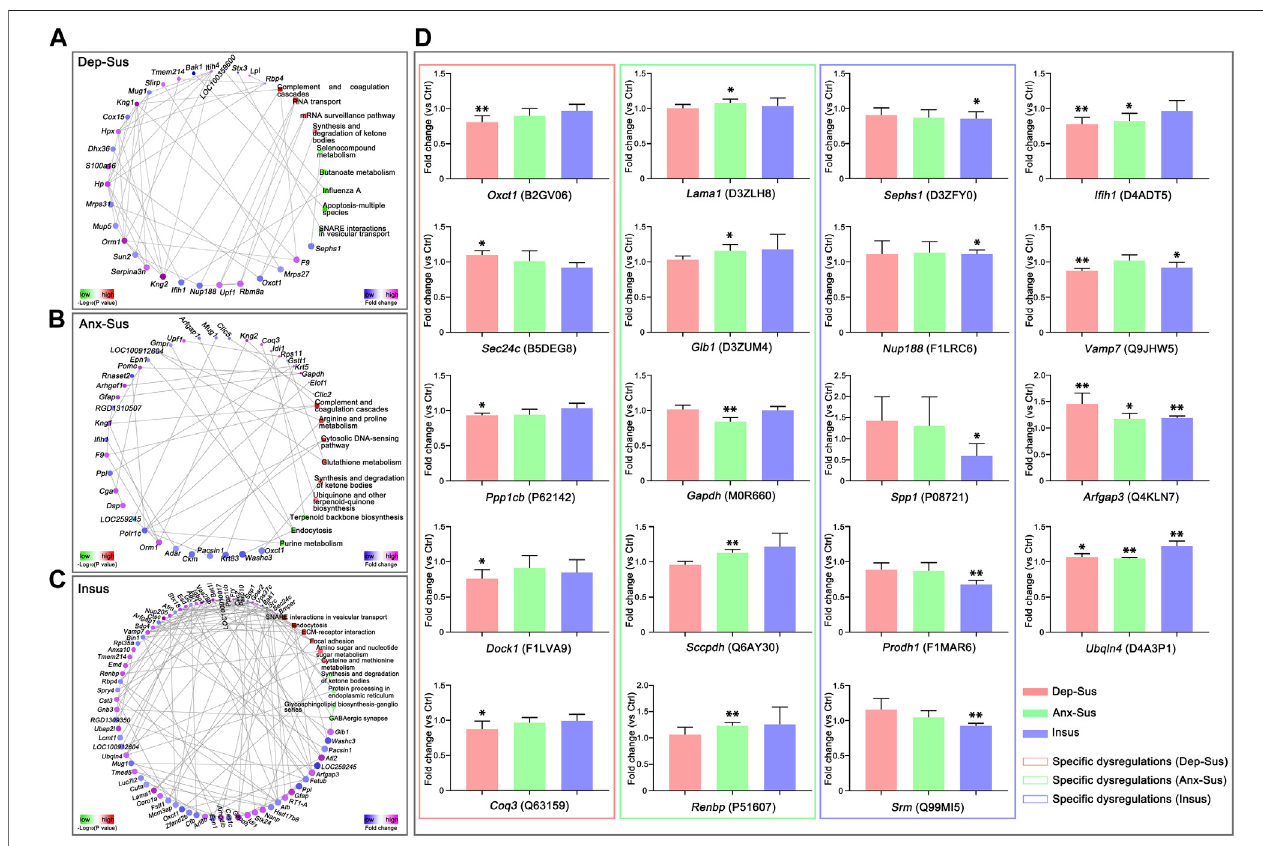
FIGURE 4 | Protein – protein interaction (PPI) network and parallel reaction monitoring (PRM) analyses of the deregulated pituitary proteins of the three groups. The PPI networks of depression-susceptible (Dep-Sus, A ), anxiety-susceptible (Anx-Sus, B ), and insusceptible (Insus, C ) were built based on fold changes of protein expression, PPIs and Kyoto Encyclopedia of Genes and Genomes (KEGG) pathway enrichments. Circular nodes represented proteins/genes and rectangles represented KEGG pathway terms. Lower p -value was indicated in blue and higher p -value in yellow. (D) PRM analysis of the deregulated proteins in the three stressed groups when compared to the control (Ctrl). Oxct1 , Sec24c , Ppp1cb , Dock1 , Coq3 , Lama1 , Glb1 , Gapdh , Sccpdh , Renbp , Sephs1 , Nup188 , Spp1 , Prodh1 , Srm , I fi h1 , Vamp7 , Arfgap3 , and Ubqln4 were determined on the pituitary protein extracts of the rats. The relative abundance of target proteins among sample groups were compared based on the abundance of the corresponding peptides. n (cid:2) 5 per group, * p < 0.05, ** p <